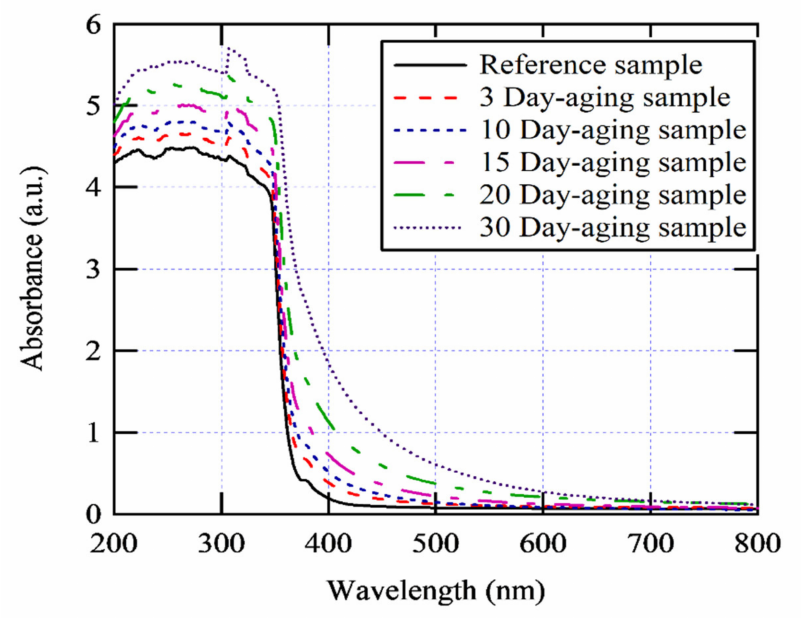
Figure 7. UV-Vis absorption spectra of different transformer oil samples with different aging